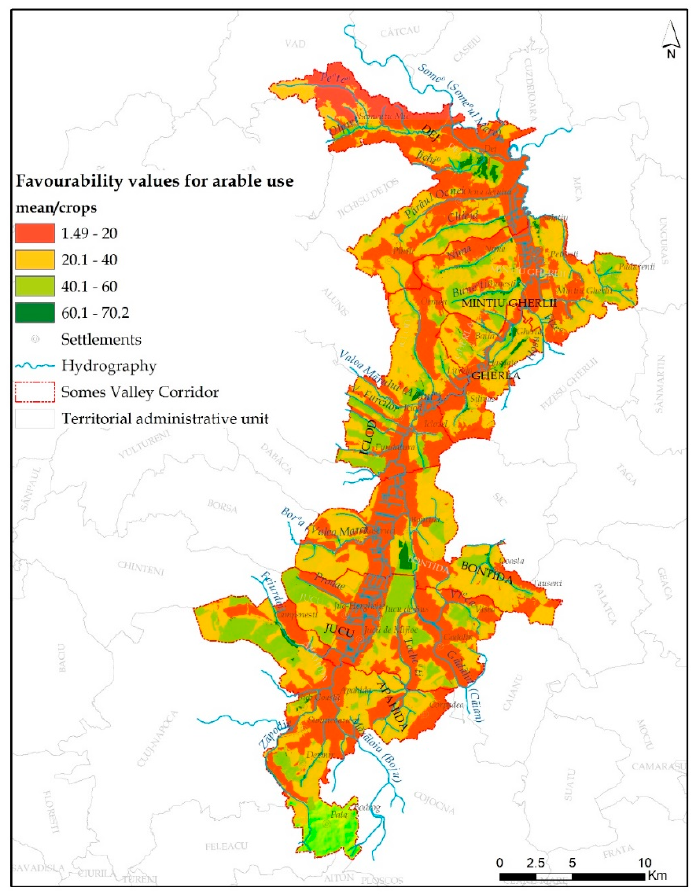
Figure 6. Map of favourability to arable use for the land parcels from the administrative-territorial units located in the corridor of the Some ș ul Mic. ,